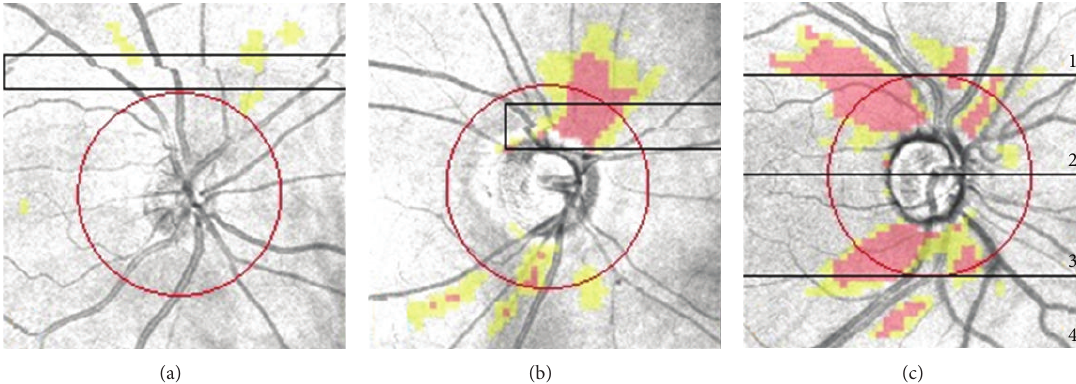
Figure 1: (a) Complete misalignment with vessel displacement of the complete scan line. Note that the misalignment occurs in the nasal direction. (b) Partial misalignment with vessel displacement of the scan. In this case, the misalignment occurs in the temporal direction. (c) Sectors used to classify the site of MAs.